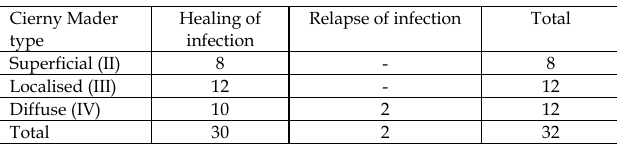
Table 3 . Results of surgical treatment assigned to bone in-